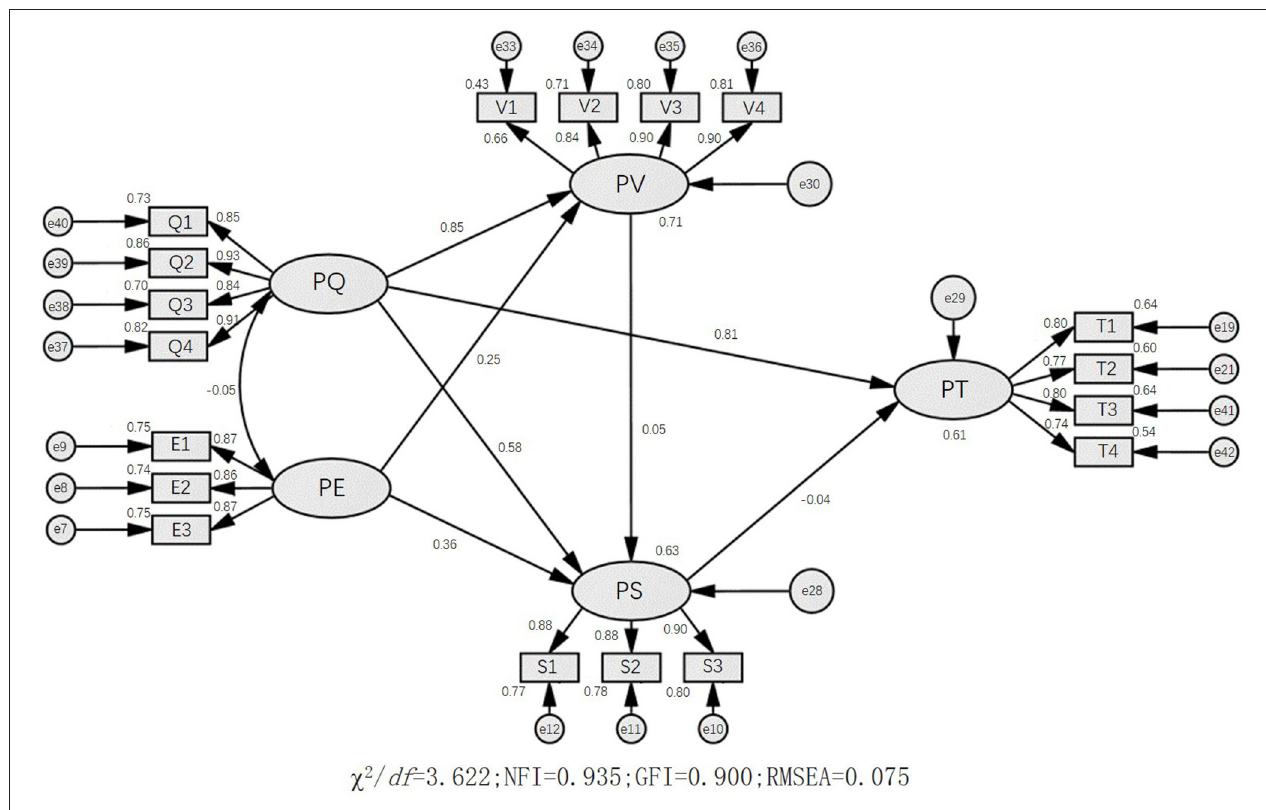
FIGURE 1 | The path relationships among five dimensions of satisfaction with health education. PQ, perceived quality; PE, public expectation; PV, perceived value; PS, public satisfaction; PT, public trust.